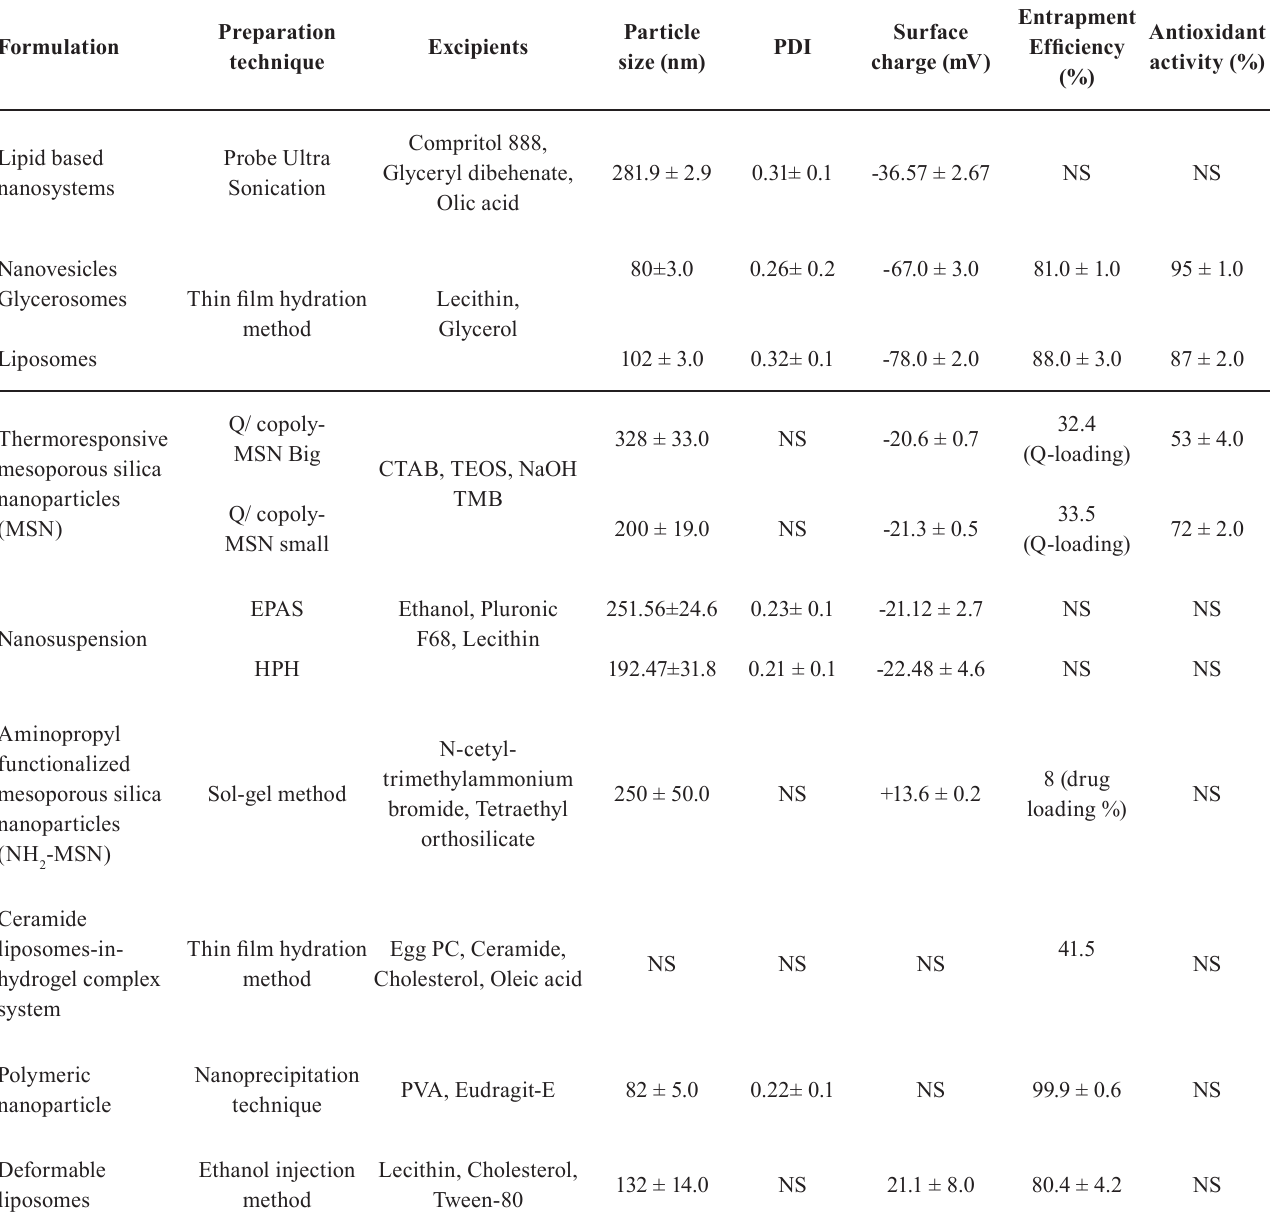
TABLE III - Comparative study of different formulations of Quercetin for topical application (Ichihashi et al . 2003); (Guo et al . 2012); (Manca et al . 2014a); (Ugazio et al . 2016); (Gao et al . 2011); (Sapino et al . 2015); (Park et al . 2013); (Wu et al . 2008) and (Yuri et al .